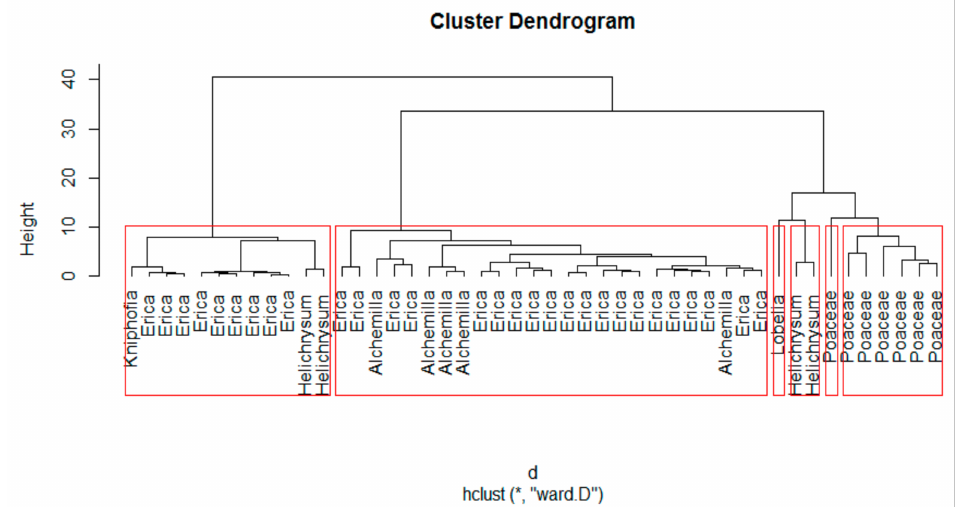
Figure 4. Agglomerated Hierarchical Cluster analysis of the dominant plant species of the Bale Mountains based on the abundance of phenolic compounds (g kg − 1 TOC). Euclidean measurement of distances and Ward method for linkage calculation applied to cluster a normalized dataset (Z-score normalization, Z = (X-mean (X)) / sd